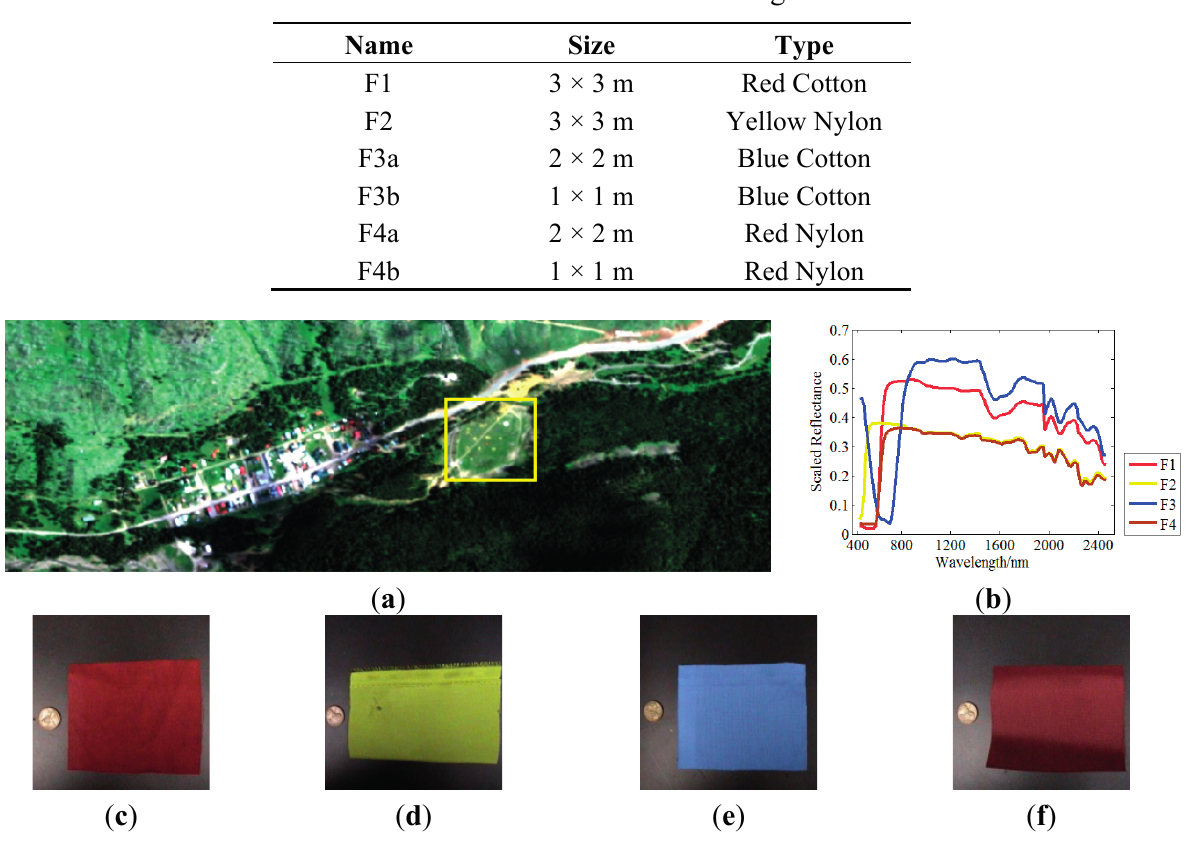
Figure 13. ( a ) RGB composites of the HyMap self-test dataset with the location of the grass region. ( b ) Four target spectral signatures. ( c – f ) Ground truth photos of targets F1, F2, F3, and F4,